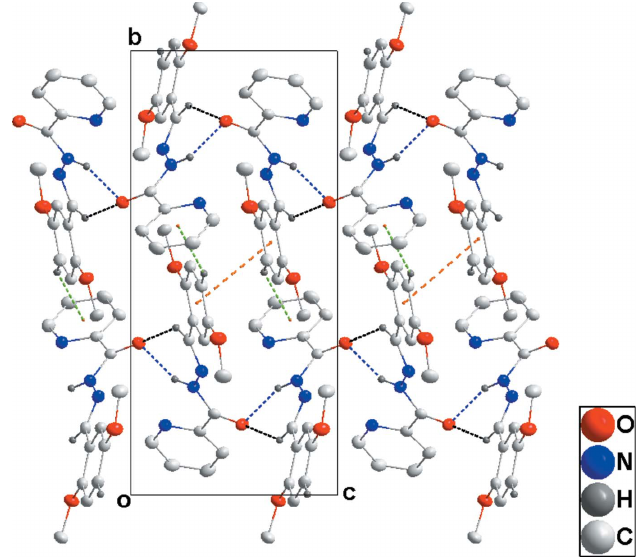
Figure 2 A view in projection along the a axis of the unit-cell contents, showing their association through offset (cid:2) – (cid:2) stacking (orange dashed lines) and C—H (cid:3)(cid:3)(cid:3) (cid:2) (ring) interactions (green dashed lines). The N—N (cid:3)(cid:3)(cid:3) O and C—H (cid:3)(cid:3)(cid:3) O hydrogen bonds are shown, respectively, as blue and black dashed lines.